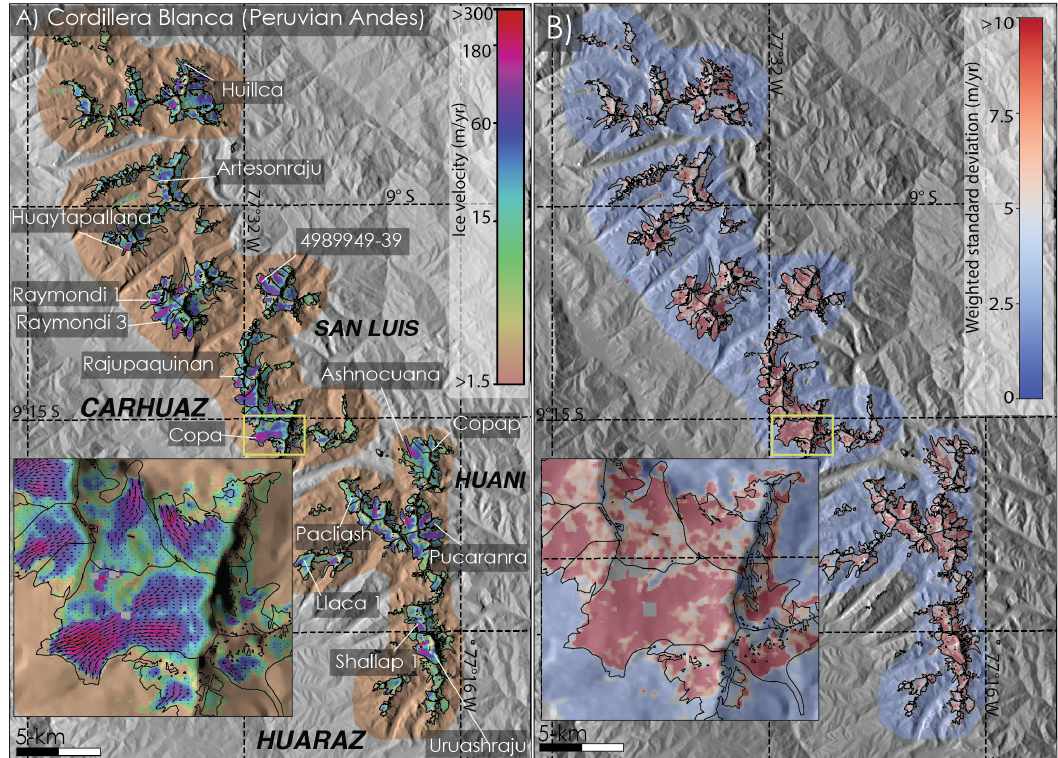
Figure 1. ( A ) Glacier surface velocity mosaic of the Cordillera Blanca (Peru) in meters per year averaged over 2017-2018 quantified from Sentinel-2 images, color-bar is coded on a logarithmic scale going from brown (slow) to red (fast) and overlaid on a shaded relief version of the SRTM DEM; ( B ) Weighted standard deviation color coded from white (low variance) to dark red (high variance). Insets show a zoom on the tongue of Copa glacier for each